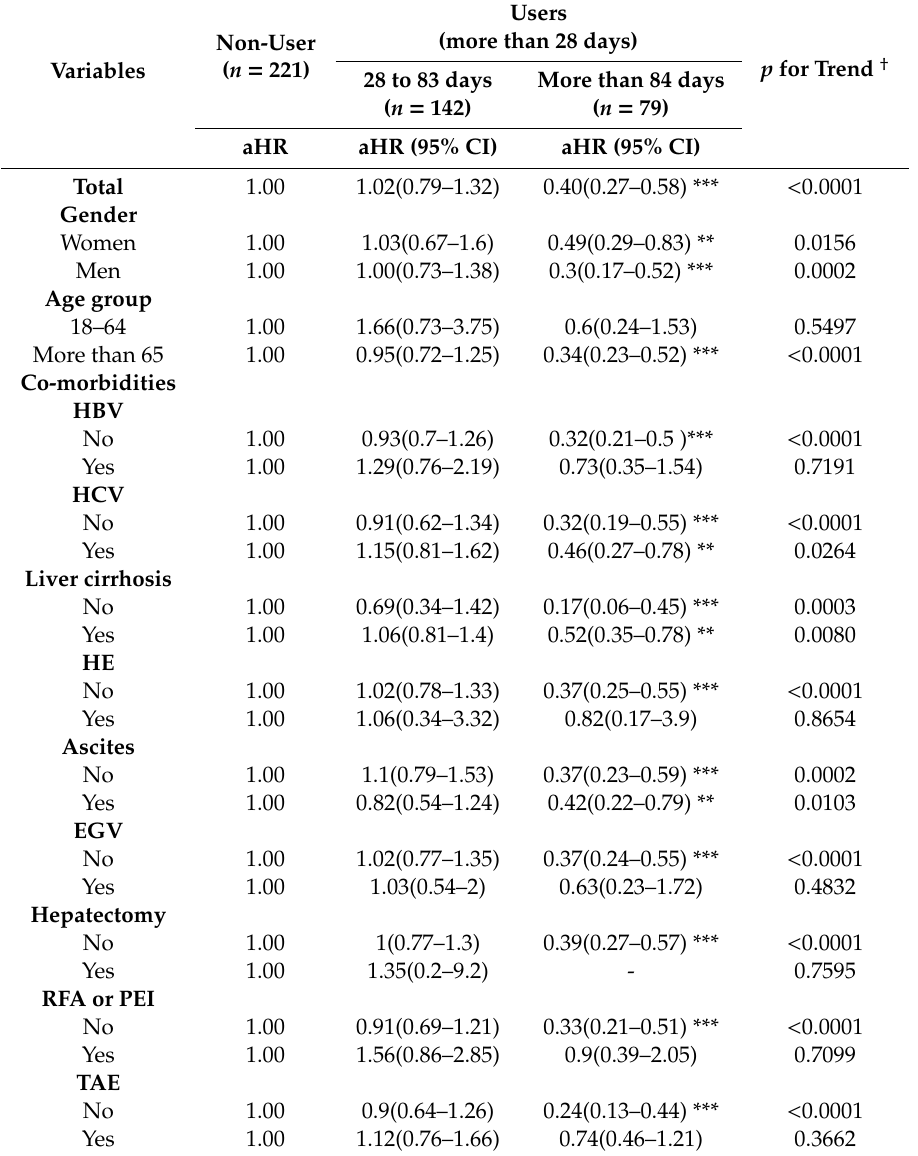
Table 3. Hazard ratios for duration of amiodarone use and mortality in arrhythmic patients with